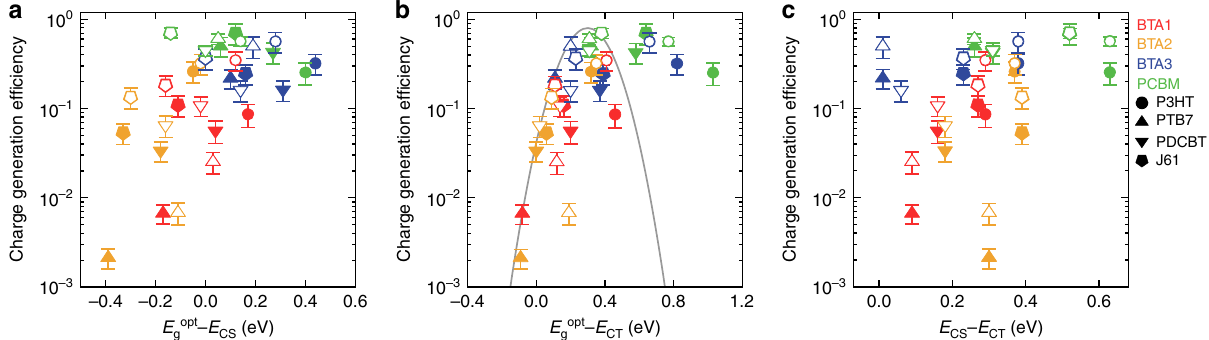
Fig. 4 Charge generation ef fi ciency and state energy difference. η gen plotted against a , E g opt − E CS , b , E g opt − E CT , and c , E CS − E CT . The fi lled and open symbols show the charge generation from the excitons generated at the donor and the acceptor sides, respectively. The error bar indicates the variation of the assumed exciton collection length. The gray line in panel b is a Gaussian derived from Marcus charge transfer theory with a reorganization energy of